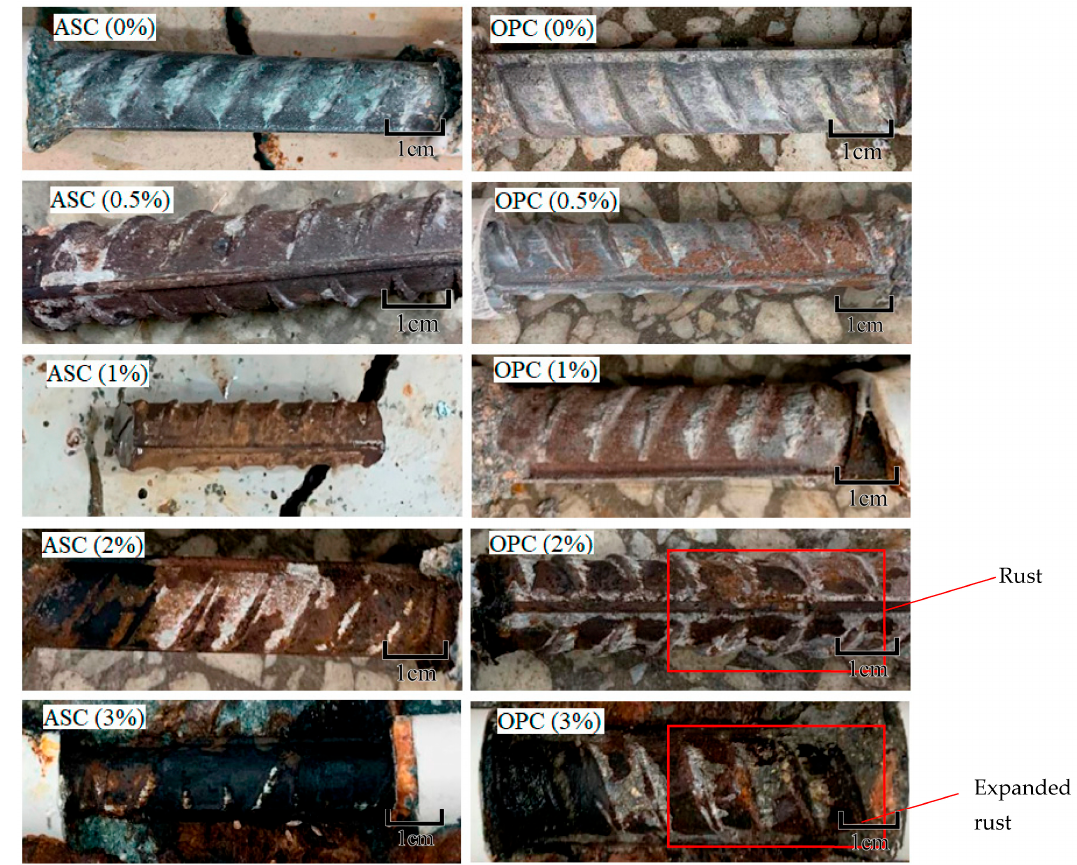
Figure 3. Steel bar corrosion in ASC and OPC at different designed corrosion degrees.